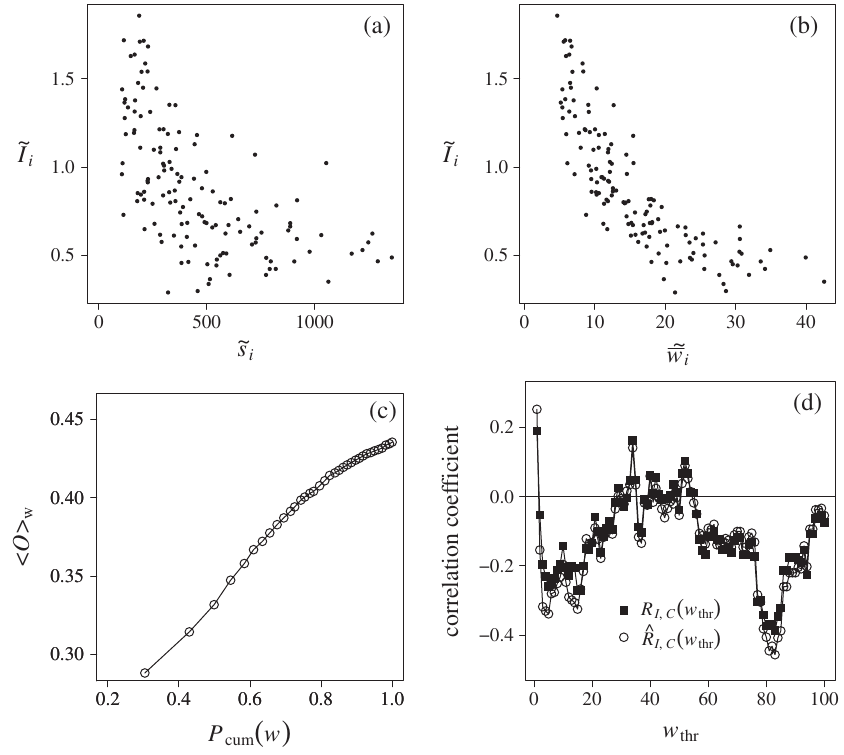
FIG. 19. Results for the interpolated data with m ¼ 5 . We use data set D